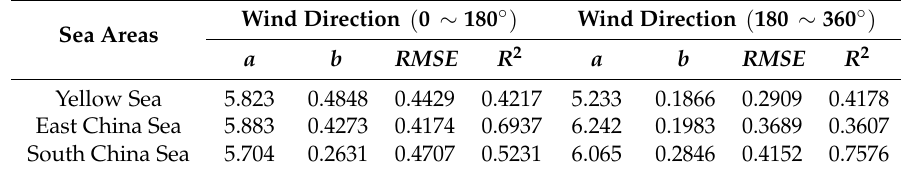
Table 3. The coefficient and performance of empirical formulas in the different seas for Equation